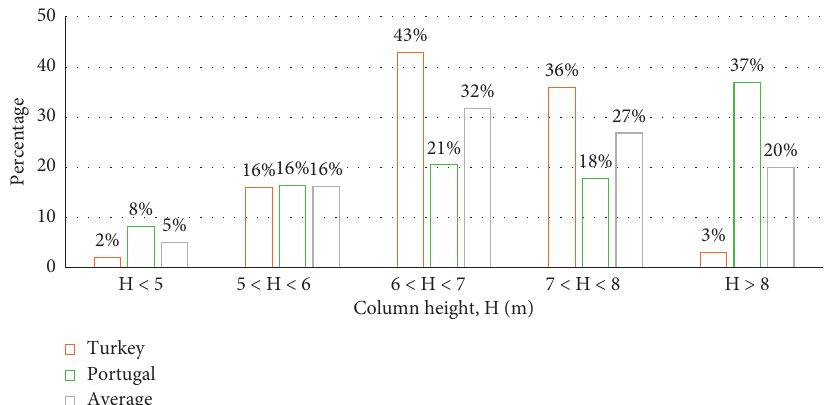
Figure 30: Comparison of column height of construction of precast RC buildings in Portugal and